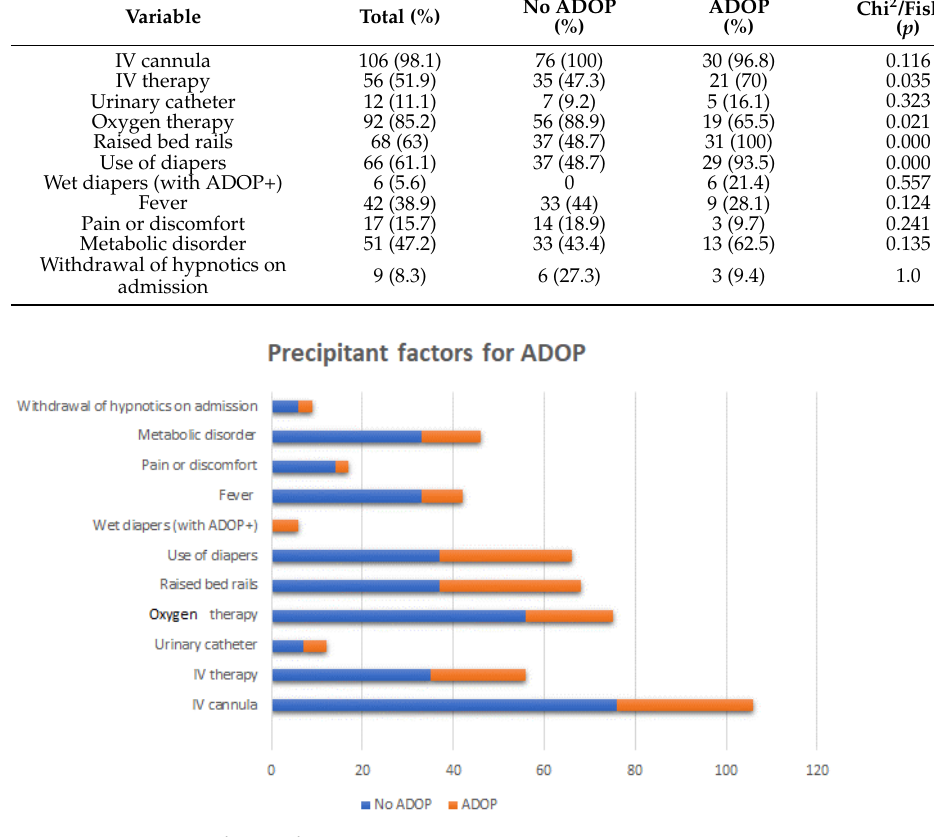
Figure 1. Precipitant factors for ADOP.